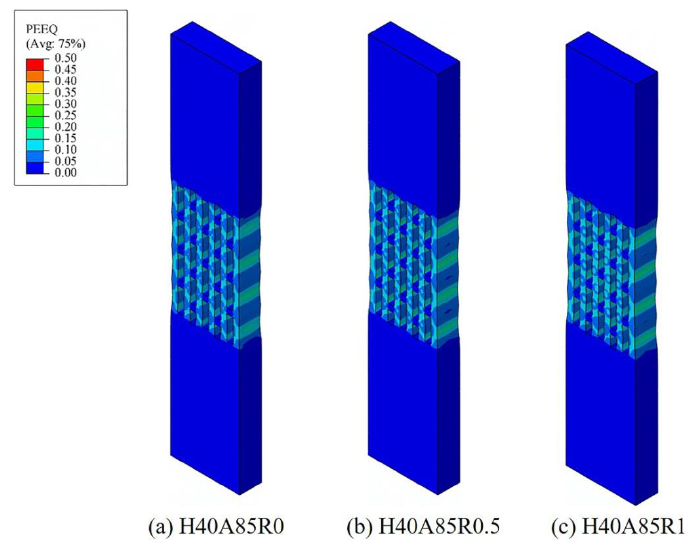
Figure 19. Effect of chamfering radius on stress triaxiality with (a) H40A85R0, (b)H40A85R0.5 and (c) H40A85R1.